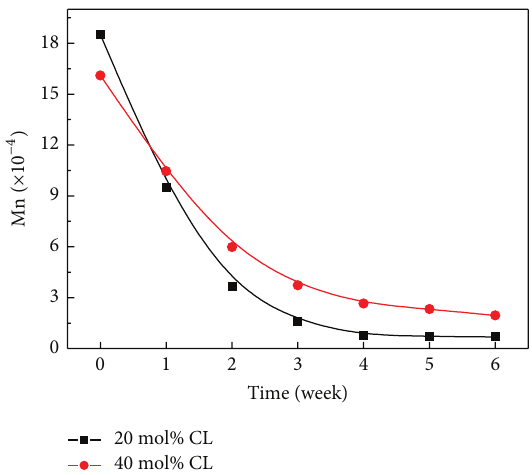
Figure 7: The changes in molecular weight of PLGC copolymers in vitro as function of degradation